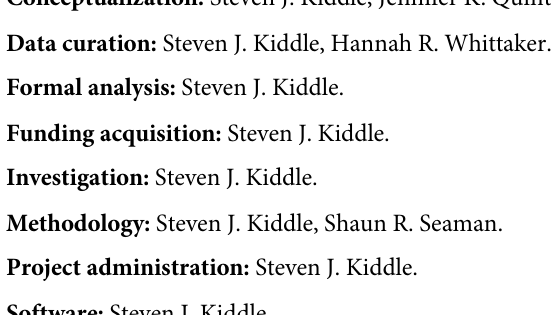
S2 Fig. Comparison of 21 variable models with each other, with basic variables only (excluding IMD) and with a larger model. Results of 5 repeats of 10-fold cross validation within the training set (80% of the linked group). Boxplot showing median and interquartile ranges for (a) prediction accuracy (Brier score), (b) discrimination (AUC = Area Under the Curve) and (c) calibration slope of the prediction models. For (a) and (b) the red dashed line indicates the best median value over all modelling strategies, whereas for (c) it indicates the perfect calibration (slope = 1). ‘CCI’ is a single variable, the Charlson Co-morbidity Index. ‘Basic–IMD (B-I)’ is a model using age, gender, smoking status, body mass index (BMI) and Forced Expiratory Volume in 1-second (FEV1) % predicted, as well as quadratic terms for age, BMI and FEV1% predicted, and not-recorded indicators for BMI and FEV1% predicted. ‘(B-I) + CCI’ adds the Charlson Co-morbidity Index (CCI) to the previous model, this index is calcu- lated using data on 16 co-morbidities. Our 21 variable model uses adds 16 co-morbidity main effects to the ‘(B-I)’ model, as such it uses the same number of variables as the ‘(B-I) + CCI’